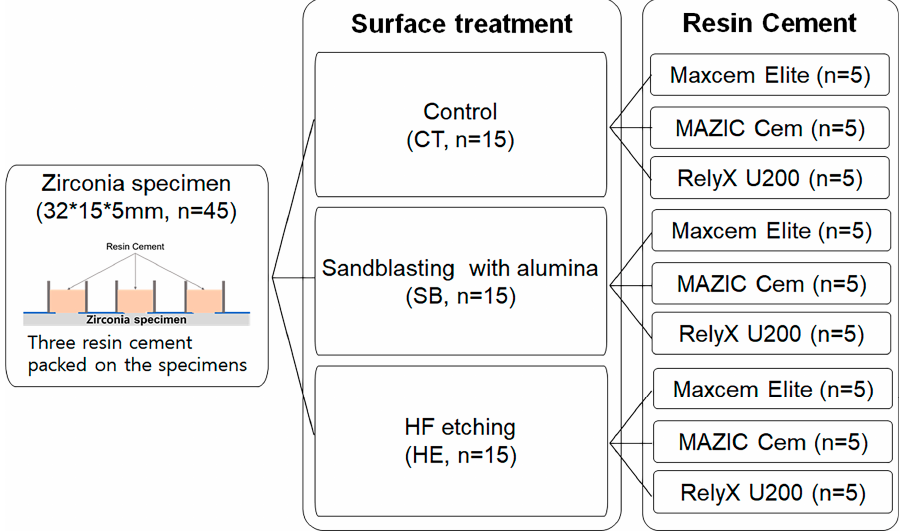
Figure 2. Schematic diagram of experimental grouping.